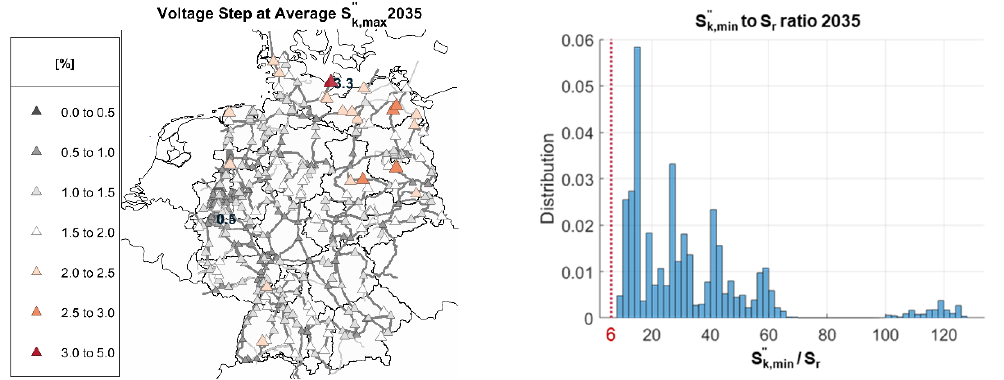
Figure 13. Relative voltage steps at average S (cid:48)(cid:48) for 2035 in Germany assuming a reactive power step of 300 Mvar ( left ) k , max